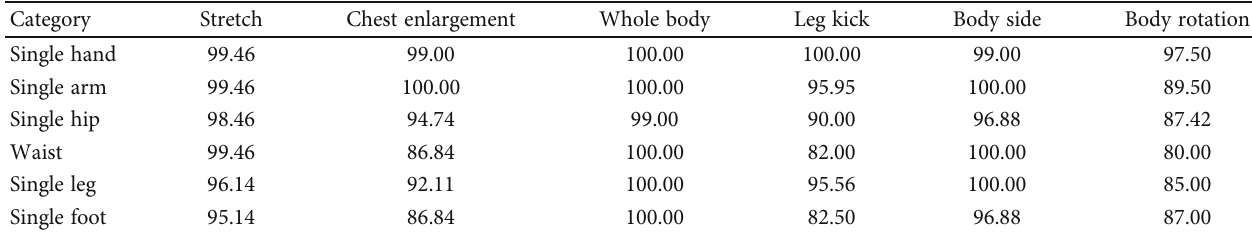
Table 2: Recognition rate based on three-axis acceleration.